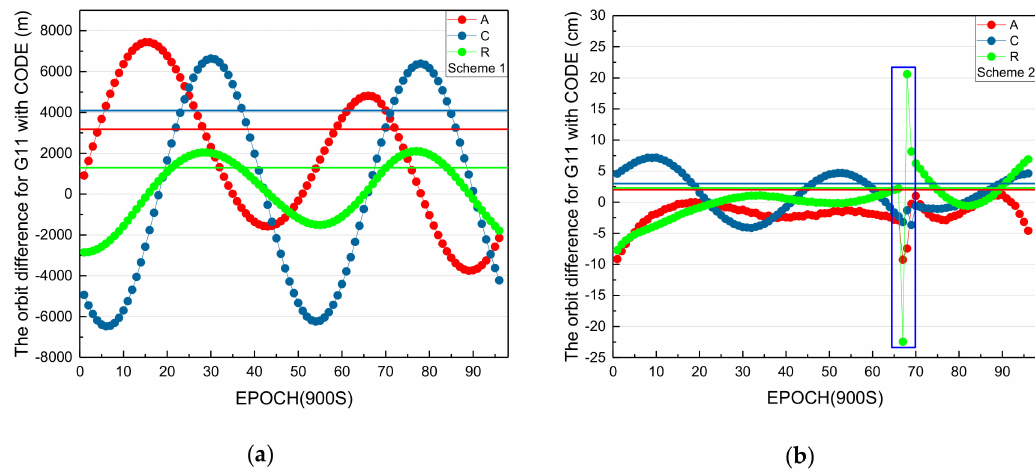
Figure 13. Di ff erences of estimated orbits with precise orbits published by Center for Orbit Determination in Europe (CODE) for G11 on 1 March 2018: ( a ) according to scheme 1 and ( b ) according to scheme 2.